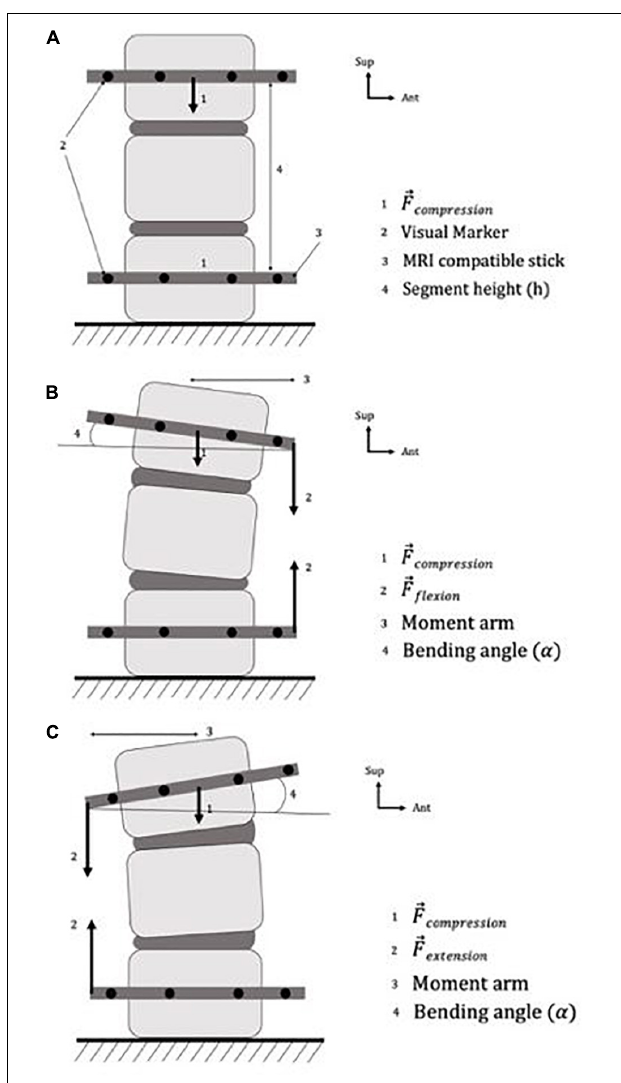
FIGURE 1 | Specimen preparation and boundary conditions of the specimen, in panels (A) neutral position, (B) flexion position, (C) extension